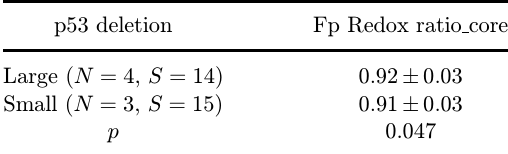
Table 5. Core (cid:1) rim univariate analysis on the